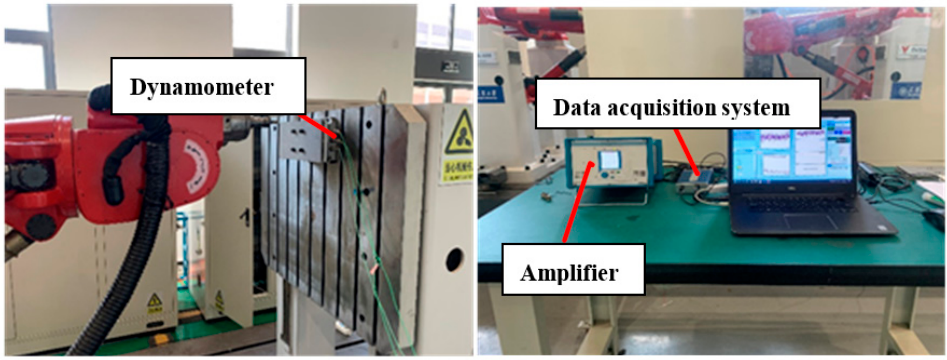
Figure 6. Experimental platform for cutting forces coefficients in TriMule based helical milling.